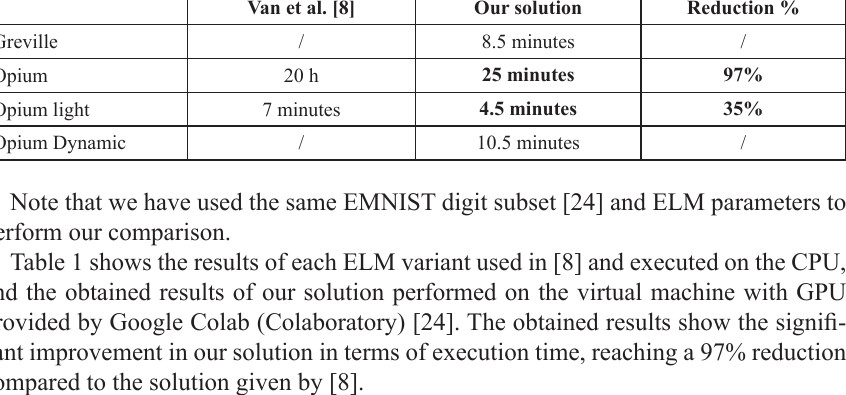
Table 1. Comparison of the ELM CPU version versus the ELM GPU version Van et al. [8] Our solution Reduction % Greville